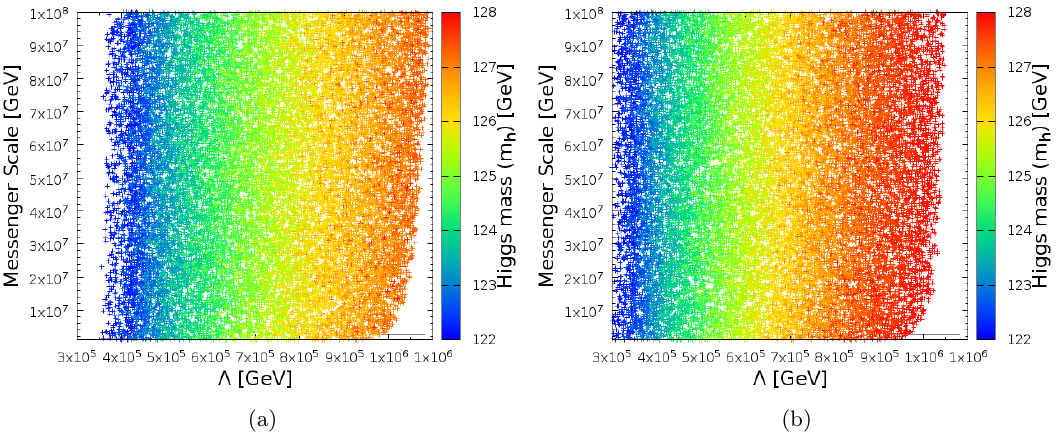
Figure 4 . Scatter plots of (cid:3) against Messenger Scale M mess for tan (cid:12) = 10 and 40 for NHmGMSB, corresponding to the scanning ranges mentioned in eq. (3.2). The side panels of each of the plots show the Higgs